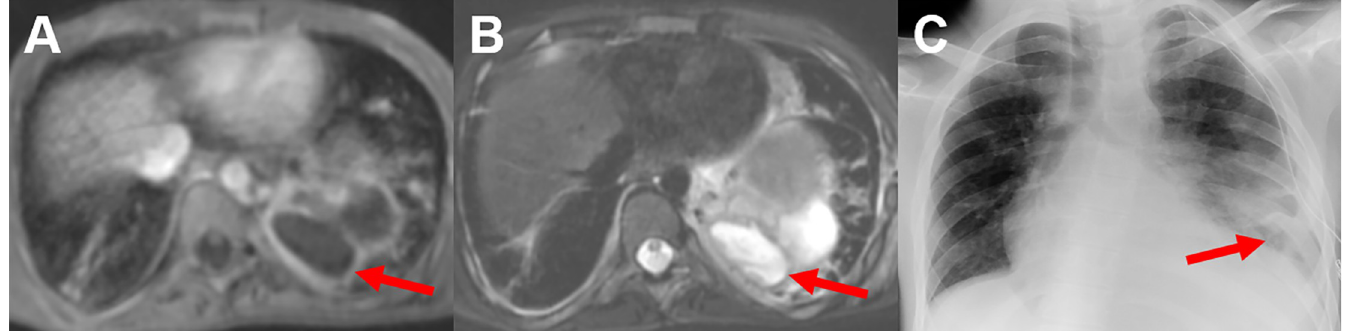
Fig 3. Contrast-enhanced T1 weighted sequence in comparison with T2 weighted sequence of a 7-year-old child. Both MRI sequences clearly delineate an abscess formation in the left lower lobe. On T1-weighting imaging (A) the abscess is characterized by the missing central contrast uptake and peripheral rim enhancement (red arrow). On T2-weighting (b), the necrotic center of the abscess has a high signal intensity, whereas the thick capsule shows a lower intensity (red arrow). The corresponding CXR (c) shows a consolidation in the left lower lung field as well as the abscess (red arrow). The example shows that the extension of abscess formations might be underestimated in